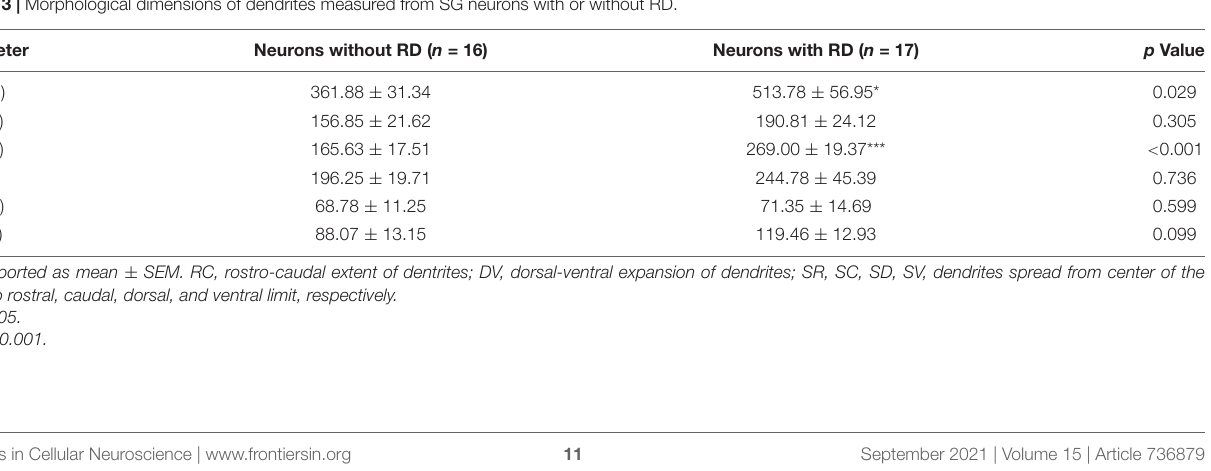
TABLE 3 | Morphological dimensions of dendrites measured from SG neurons with or without